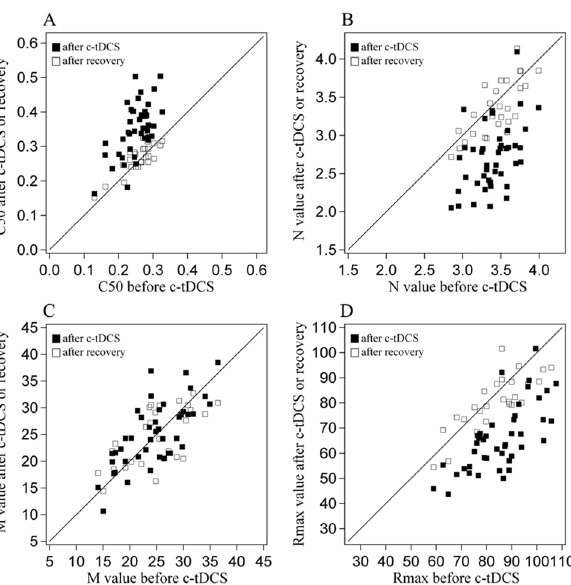
Figure 6. Scatter plots showing the best-fitting parameter value of contrast-response functions for V1 neurons across all preferred spatial frequencies (SFs). Solid squares in each plot represent individual data after versus before cathode-tDCS, and open squares indicate data of post-recovery versus before cathode-tDCS. ( A ) Stimulus contrast generating the half amplitude of maximum visually evoked response (C 50 ); ( B ) Exponents of contrast response function (N); ( C ) Spontaneous activity or baseline response (M); ( D ) Maximum visually evoked response (Rmax). Image created using Igor (version 6.3.1.2, www. wavem etrics.